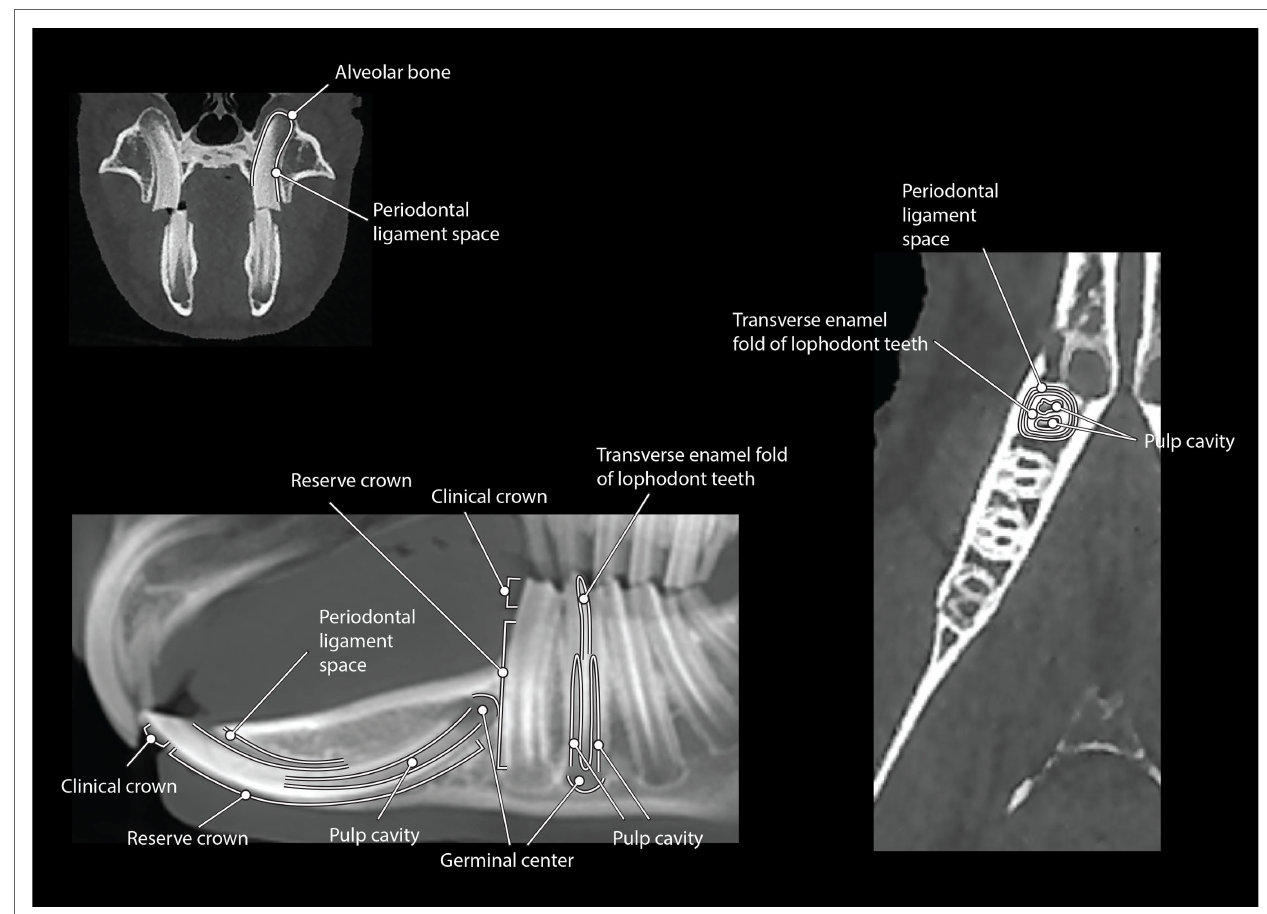
FigUre 2 | The cBcT dental anatomy of a rabbit viewed in dorsal (right), transverse (top left), and MPr sagittal (bottom left) views within the section tab